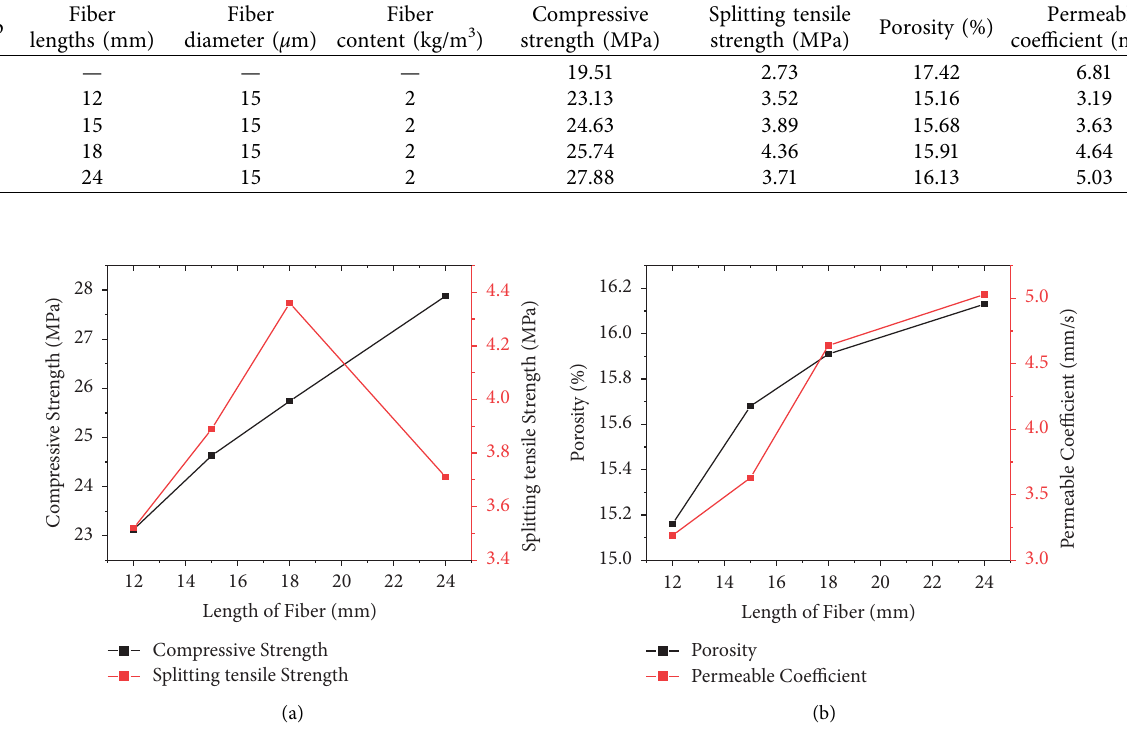
Figure 13: Broken line diagram of infuence of diferent basalt fber lengths on pervious concrete properties. (a) Relationship between fber length and mechanical properties. (b) Relationship between fber length and water